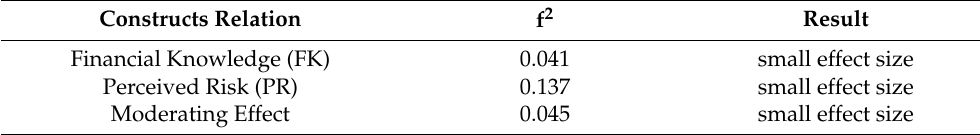
Table 6. Assessment of effect size (f 2 ).